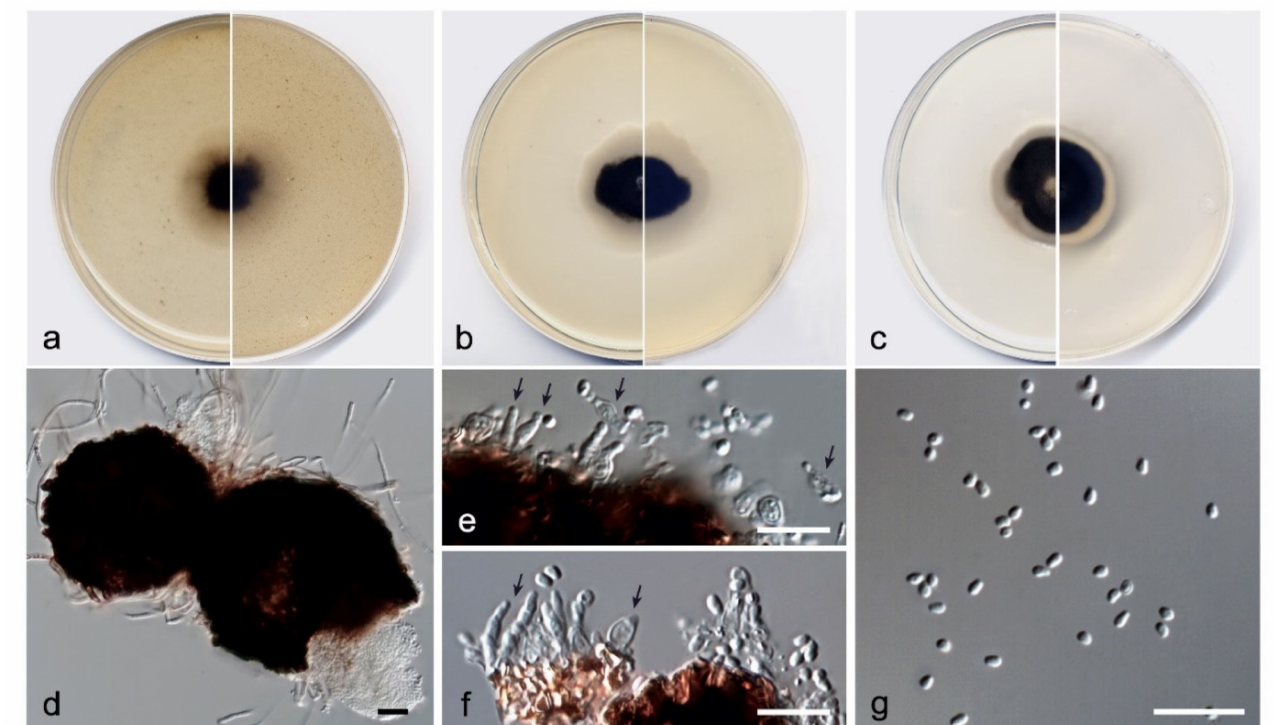
Figure 9. Amniculicola asexualis FMR 17946. ( a ) Colonies on OA ( b ) MEA ( c ) and PDA after two weeks at 25 + 1 ◦ C (surface, left; reverse, right); ( d ) Pycnidia; ( e , f ) Conidiogenous cells (black arrows); ( g ) Conidia. Scale bars = 10 µ